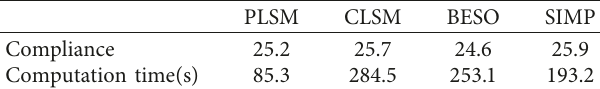
Table 1: Comparison of results of different methods in form finding of deck arch bridge.